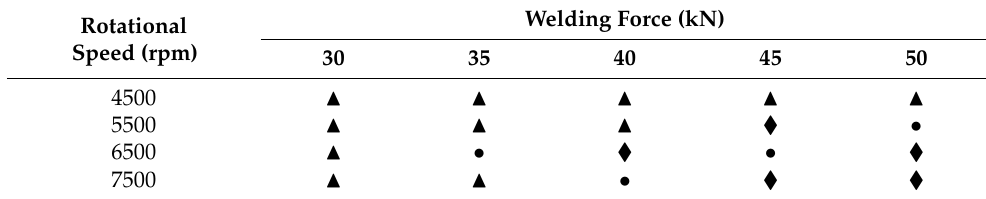
Table 4. Fracture location of FPW joints.